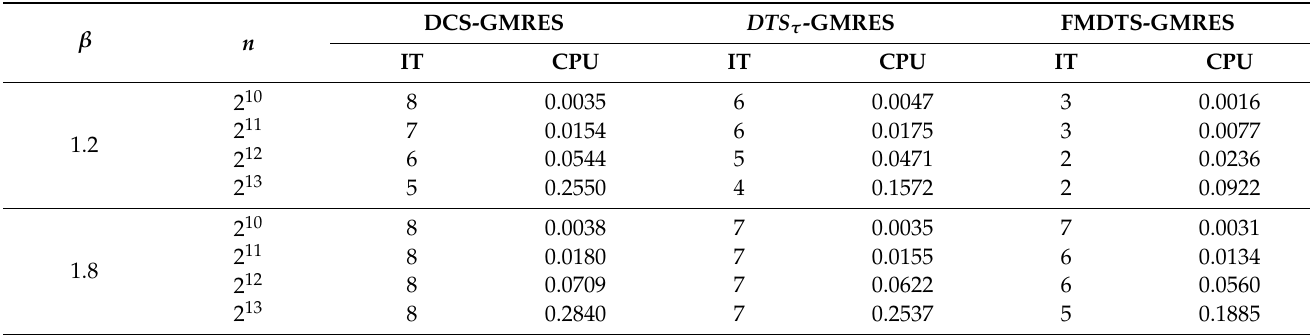
Table 2. Numerical results for solving Example 2.